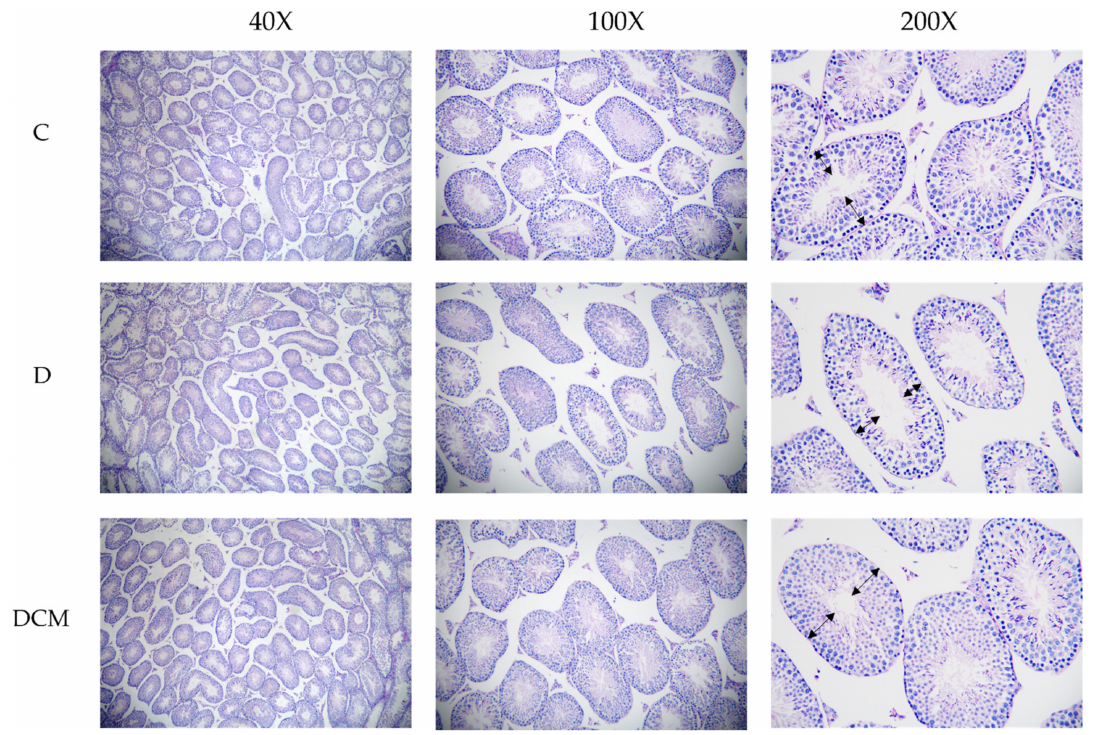
Figure 5. Histopathological analysis of C3G on PAS-stained testis of mice in DSS-induced colitis. ←→ : Thickness of spermatogenic epithelium.